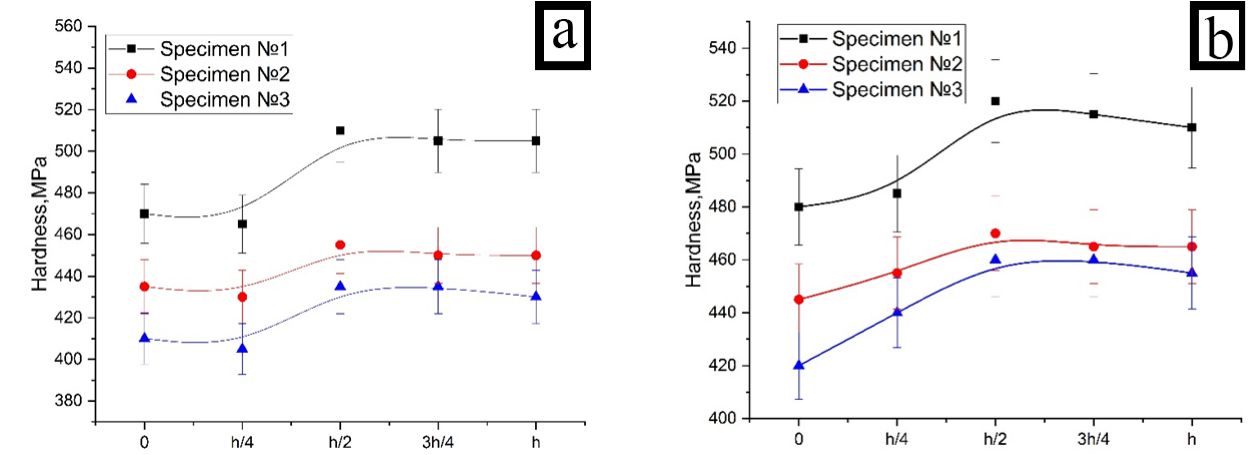
Figure 11. Distribution of hardness values along the height of the cross-section of the specimens: ( a ) in the central part; ( b ) in the extreme lateral part.